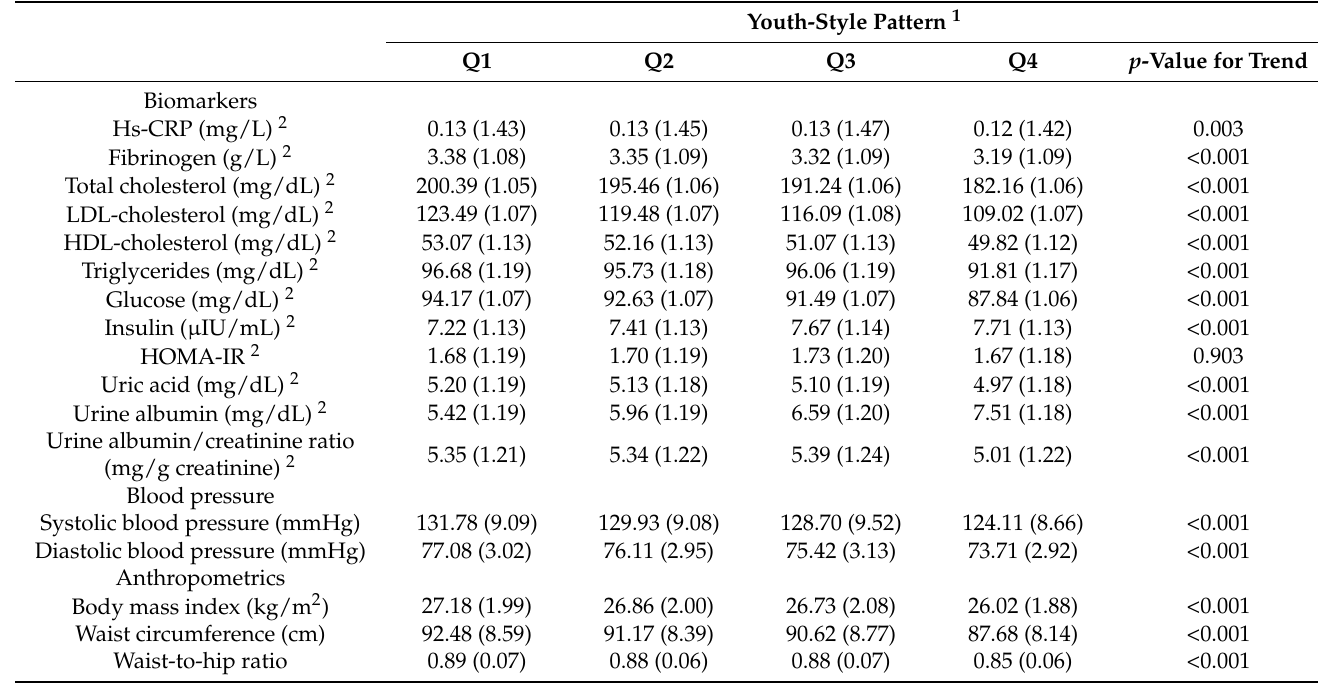
Table 5. Plasma and urine concentrations of inflammatory and cardio-metabolic biomarkers, blood pressure, and anthropo- metrics according to the quartiles of the youth-style pattern 1 .